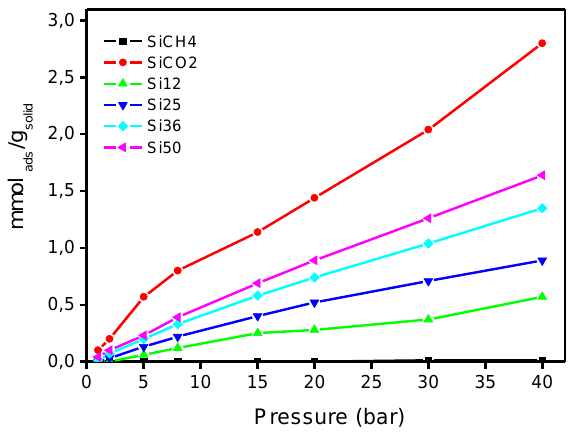
Figure 7. Adsorption isotherms